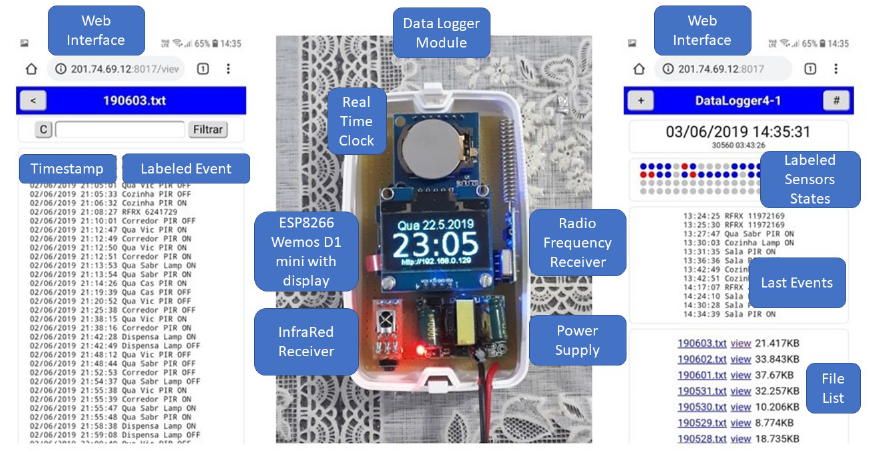
Figure 6. Data Logger module with Real Time Clock, compatible with Radio Frequency (RF433) signals, WiFi connectivity (Access Point and Client) with 3MB file system based on ESP8266 IoT development board. The log capability in the Brazilian smart home test bed with 20 sensors and four residents was of one